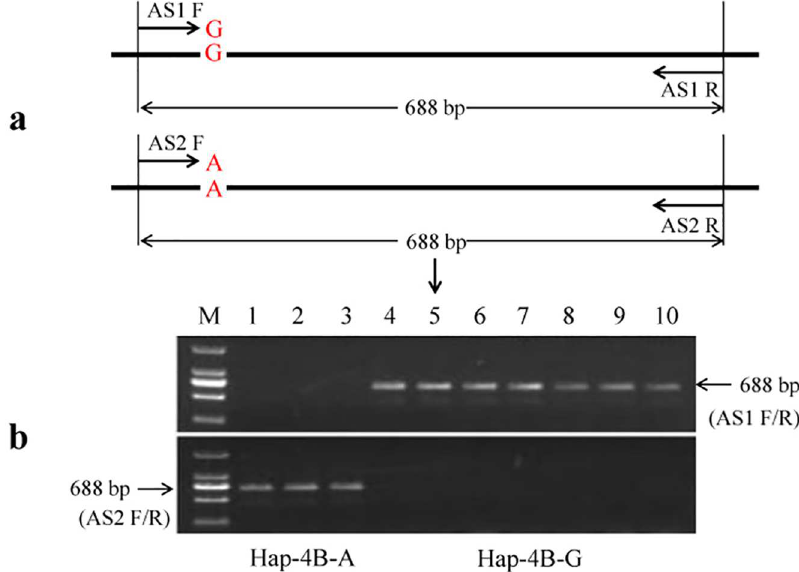
Fig 5. Functional markerdevelopment based a SNP found in the fourth intron of TaSnRK2 . 10-4B . (a) Schematic diagramshowingthe AS-PCR approach used tovalidatethe SNP. (b) PCR fragments amplifiedwith the markers TaSnRK2 . 10-4B-AS1 and TaSnRK2 . 10-4B-AS2 in ten Chinese wheatvarieties. TaSnRK2 . 10- 4B-AS1 yieldeda 688 bp PCR fragment in varietieswith the Hap-4B-G allele,and TaSnRK2 .